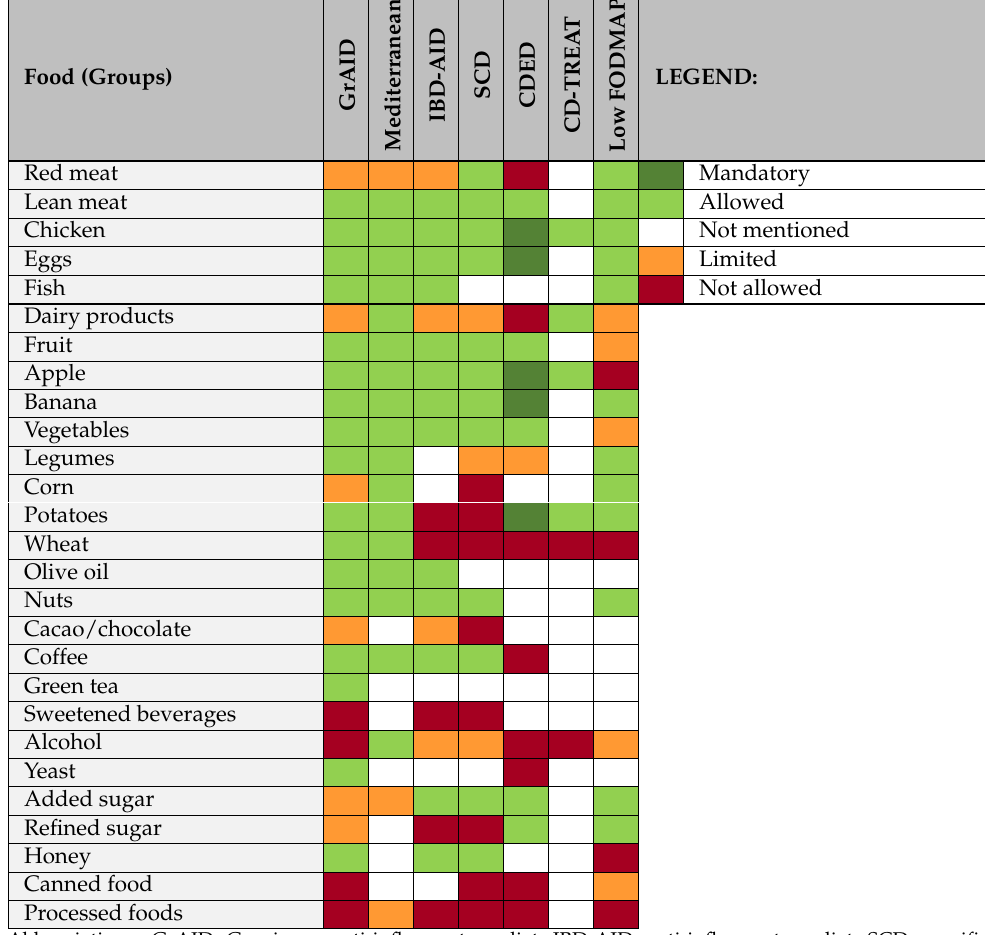
Table 1. Overview of GrAID compared to diets being tested in inflammatory bowel disease with mandatory, allowed, limited and not allowed food